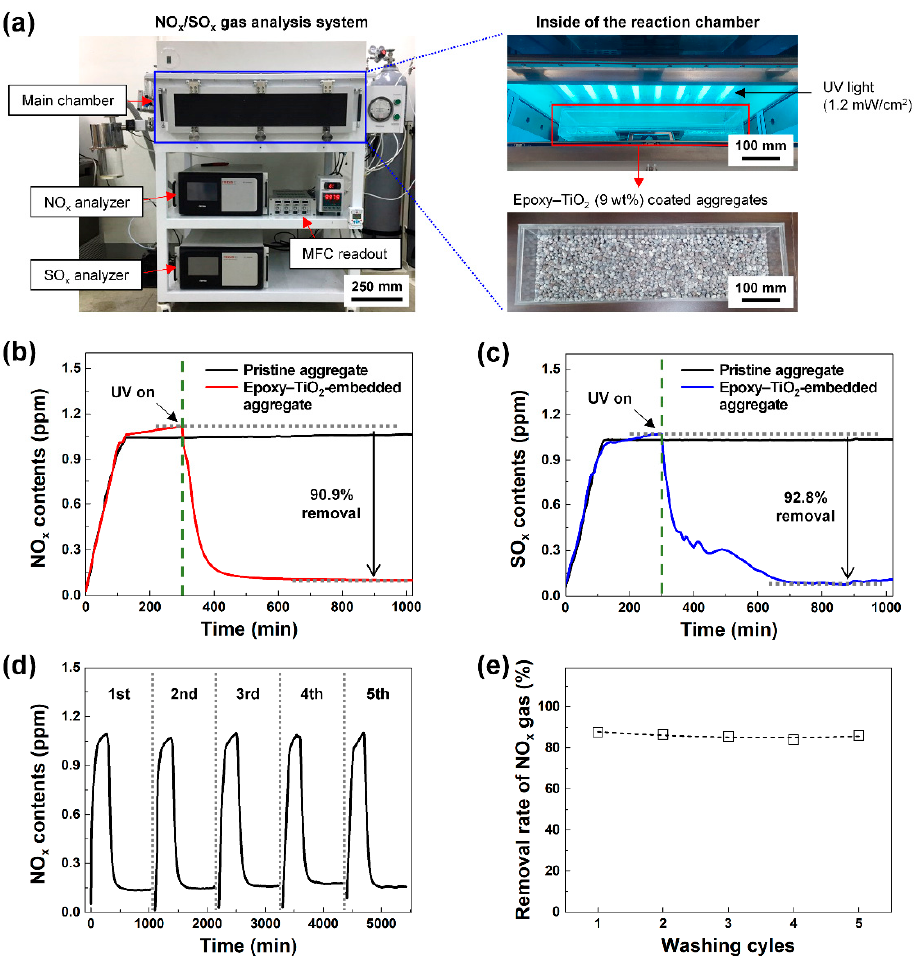
Figure 4. NO x /SO x adsorption capacities of the epoxy–TiO 2 -embedded high-strength functional LWA. ( a ) Images of the exterior and interior of the reaction chamber of the NO x /SO x gas analysis system. ( b ) NO x and ( c ) SO x reduction properties of the pristine LWA and the epoxy–TiO 2 -embedded high-strength functional LWA. Dotted line is a baseline for extracting the maximum removal rate of NO x and SO x when UV is turned on. ( d ) The result of measuring the reduction of NO x gas after 5 times of repeated water washing. ( e ) Changes in NO x gas removal rate through the water washing cycles.